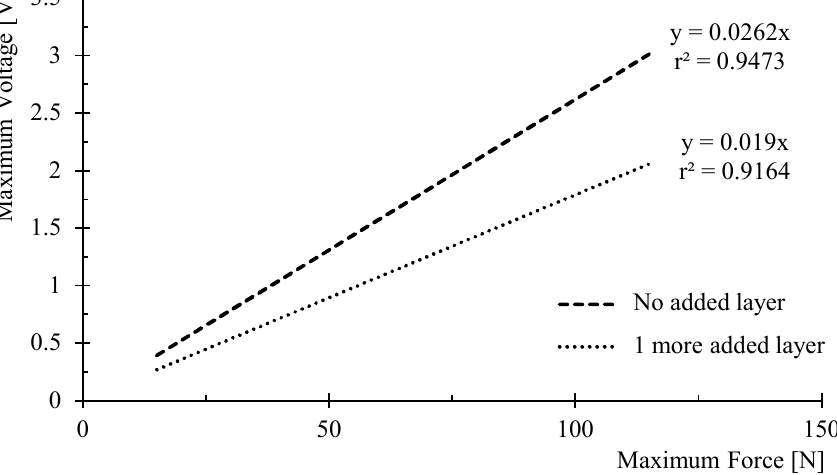
Figure 10. The effect of one protection layer on the sensor sensitivity for home-made PVDF sensor.